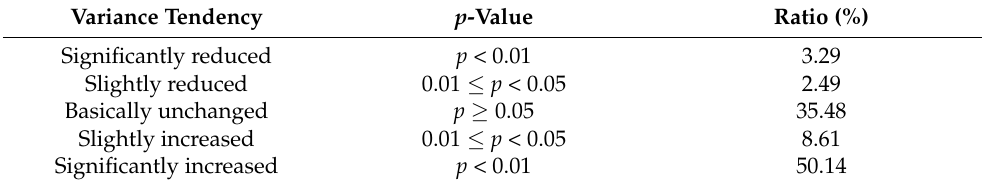
Figure 7. Variance tendency of interannual NDVI over Southwest China from 1982 to 2015. Table 3. The area ratio of different variance tendency of NDVI over Southwest China during